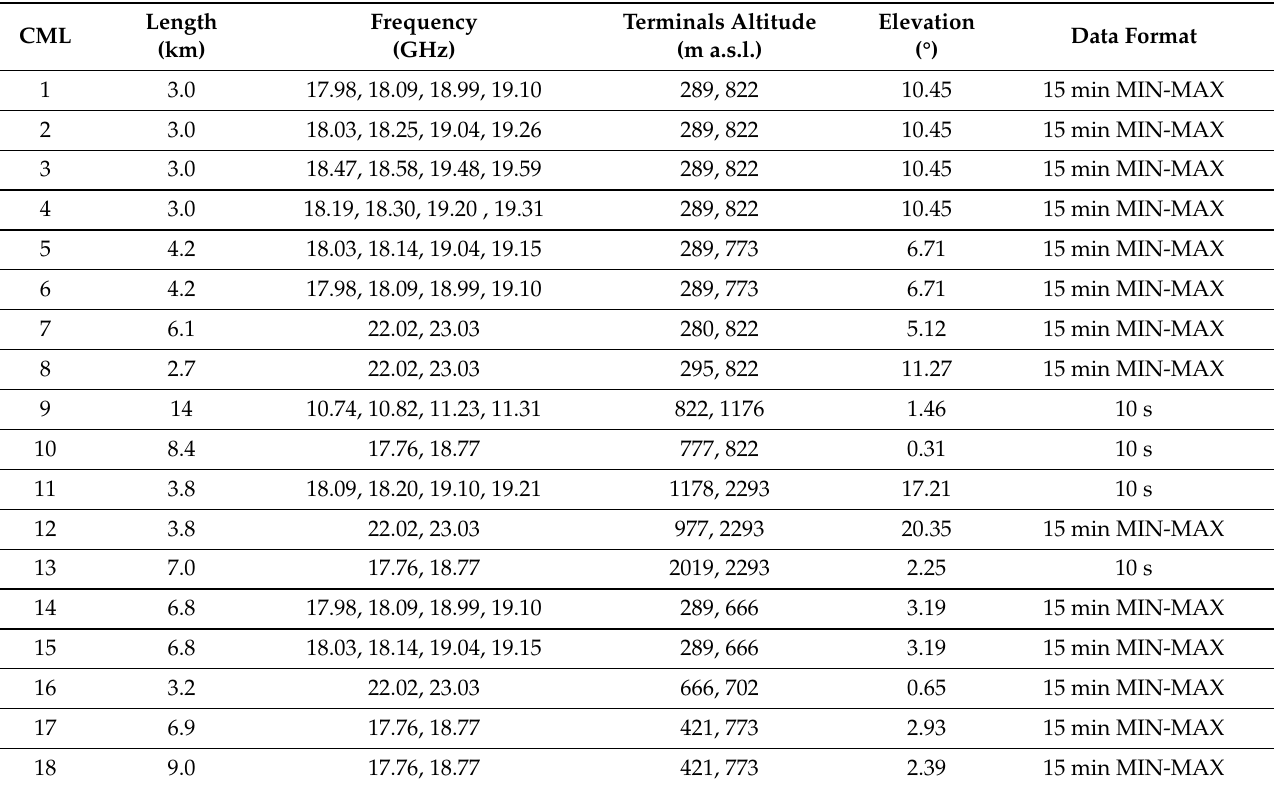
Table 1. Characteristics of the 18 CML used in this